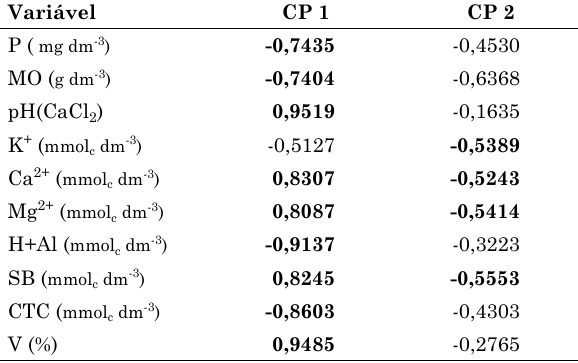
RS5N5RS4N5 PL1N4RU9N4 PL8N6 PL7N6PL3N5 RC6N5/6PL2N6 CAP PL10N6 Figura 3. Dendrograma resultante da análise de agrupamento das diferentes áreas, utilizando a distância euclidiana como coeficiente de similaridade e o algoritmo single linkage como método de agrupamento quanto aos atributos